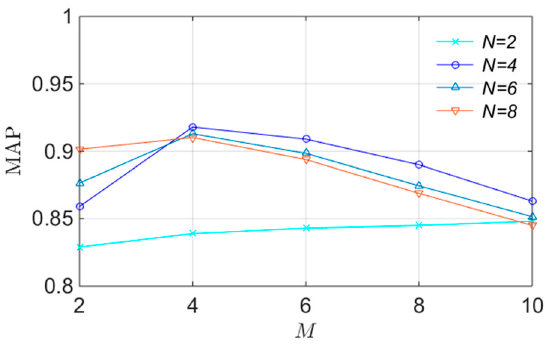
Figure 7. The e ff ects of M and N on accuracy. Figure 7. The effects of M and N on accuracy.